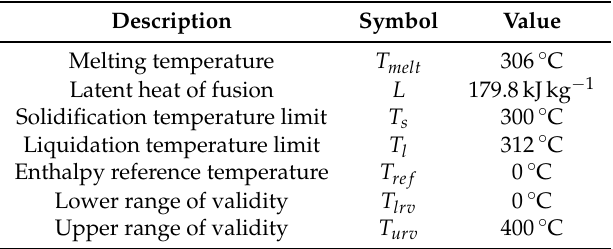
Table 2. Properties and boundary values of sodium nitrate for the specific enthalpy